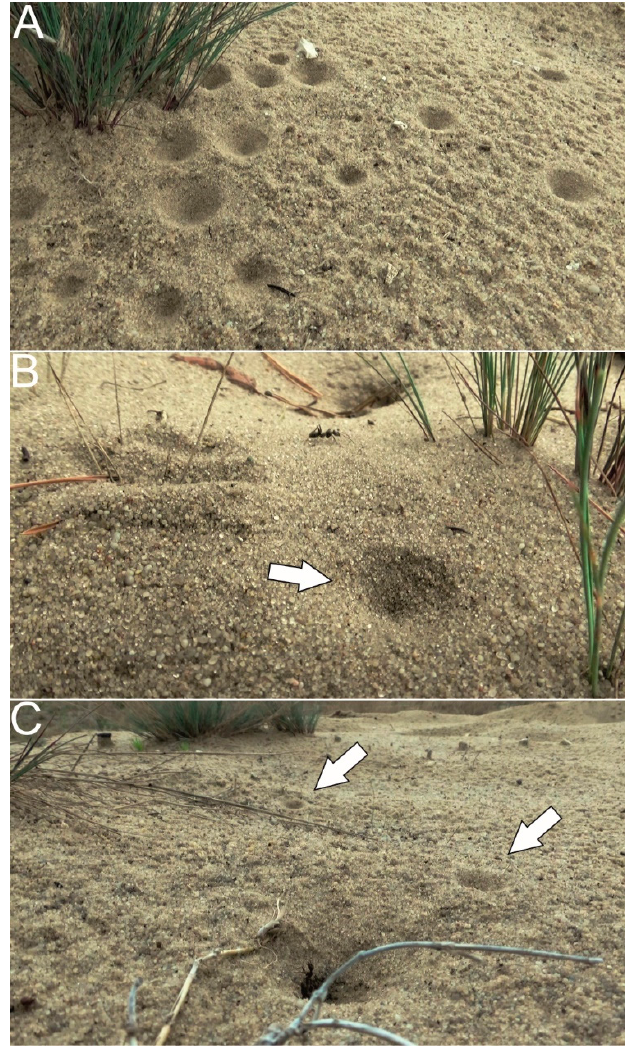
Figure 1. Ant rescue actions in the field might be observed in the context of capture by predatory antlion larvae. Aggregation of traps built by antlions in the habitat shared with sand-dwelling ants, such as F. cinerea ( A ). Traps of antlions (indicated by arrows) close to nest entrances of F. cinerea , with visible forager workers ( B , C ). The traps are 2–5 cm in diameter. Photographs: F. Turza, Bł˛edowska Desert (southern Poland).